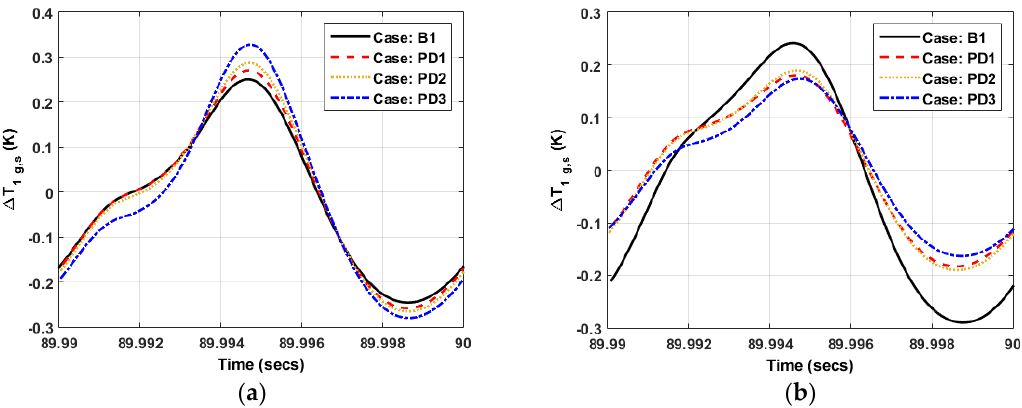
Figure 13. Comparison of ∆𝑇 1| for different length combinations at ( a ) CHX ( b ) stack cold end. 𝑔,𝑠 Axial distribution of time-averaged temperature along the stack length is depicted in Figure 14.